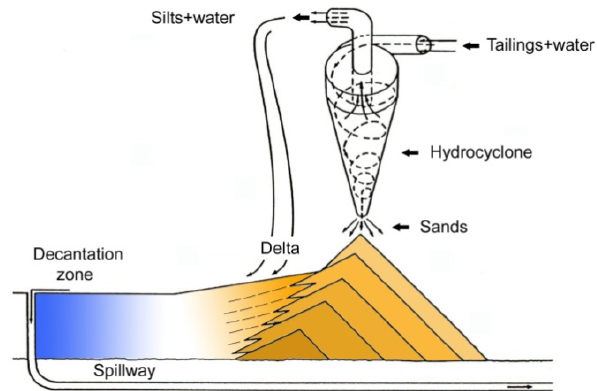
Fig. 4 – The embankments of the landfill minings are made through a process of centrifugation in a hydrocyclone in which are channeled the mud; sand is separated and used to realize the embankment, while the finer fraction, constituted by silty mud to settle, is discharged into the reservoir through a pipe (from Watermeyer and Williamson, 1979, modified).